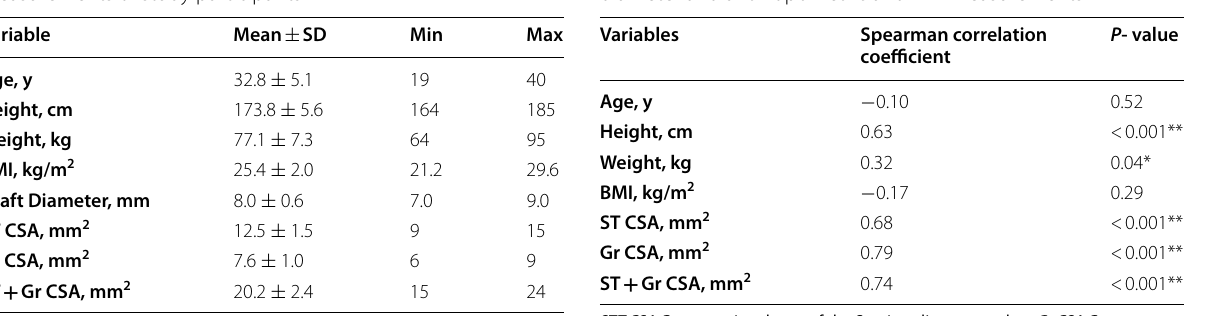
Table 1 Anthropometric